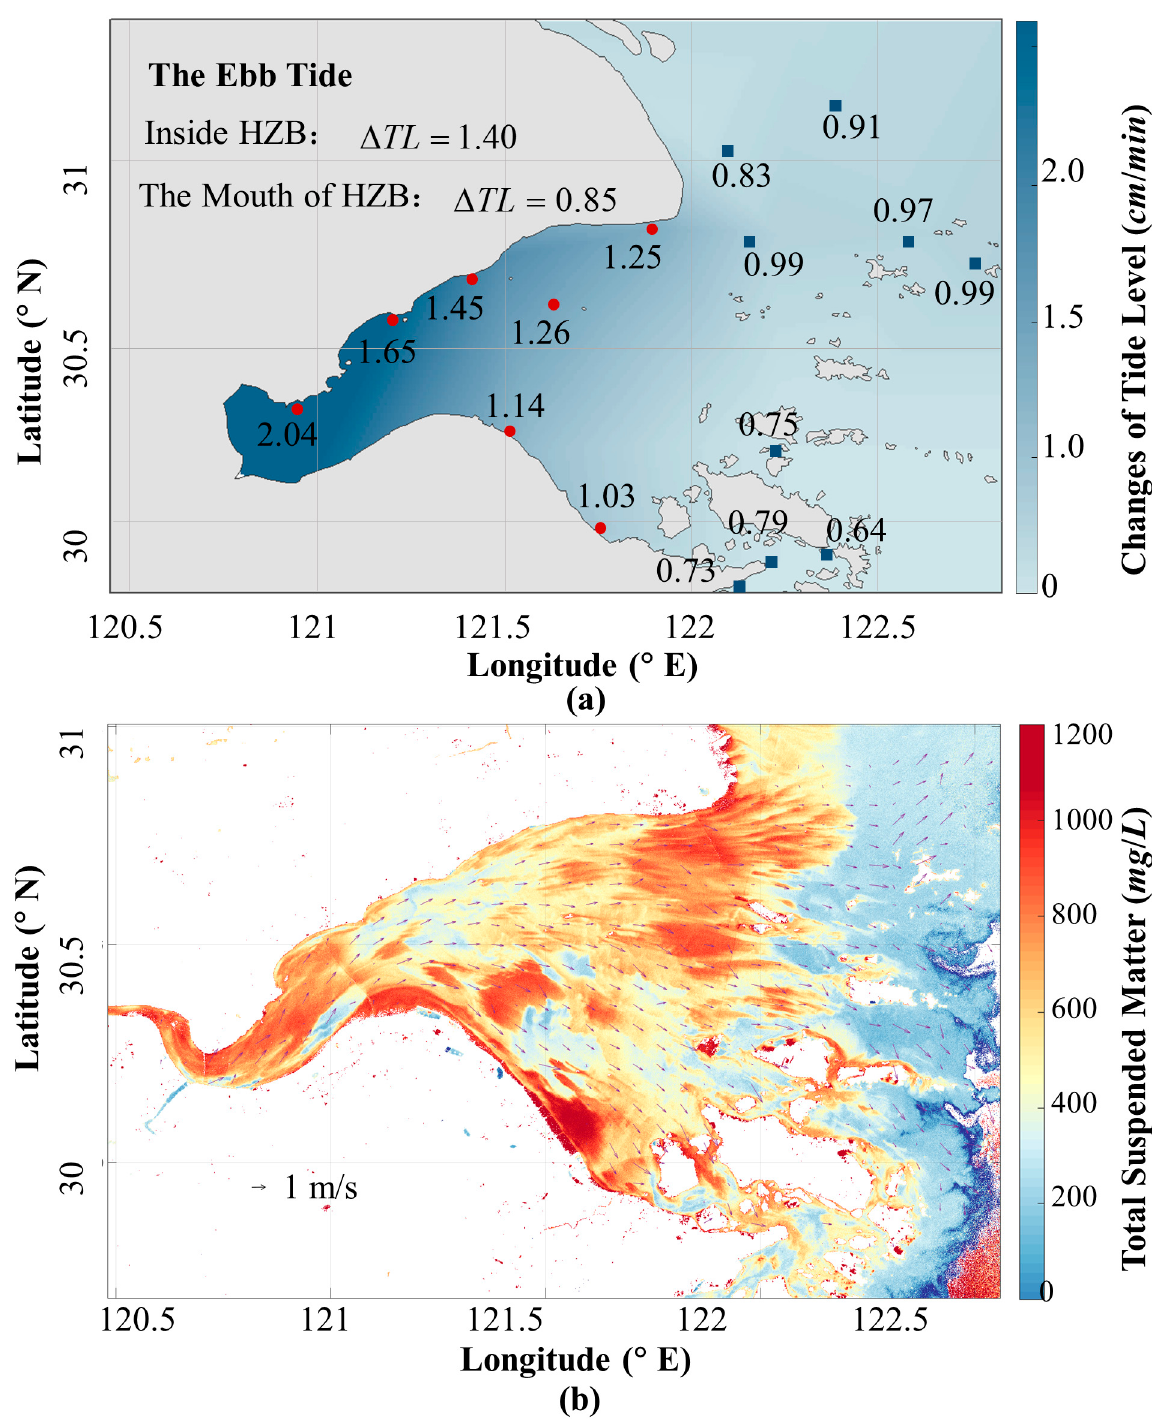
Figure 9. ( a ) The minute scale variation of tide levels at different tide stations at ebb tide. The red points represent the location of tide stations inside HZB, and the blue squares represent the location of the tide station outside HZB. ( b ) The average velocity of current within 10 min at ebb tide in HZB, which is calculated by TSM.